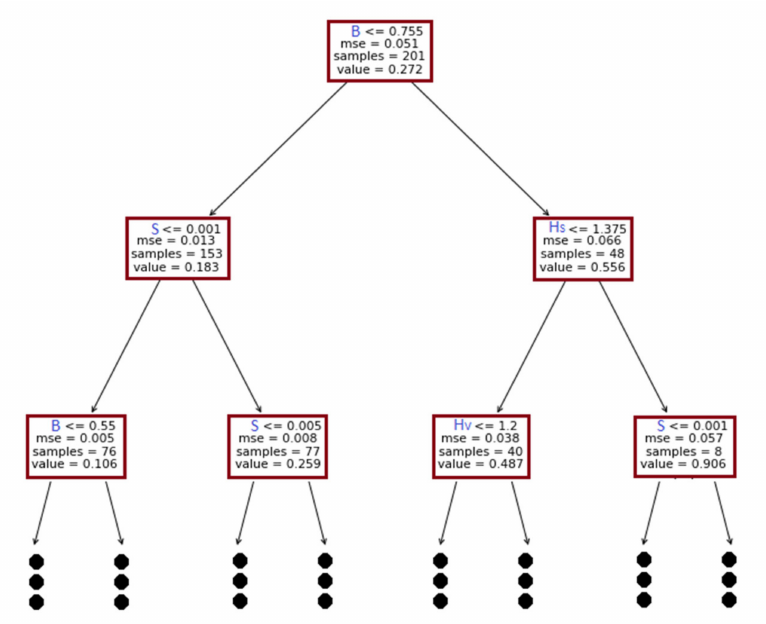
Figure 11. First three layers of the decision tree used in this